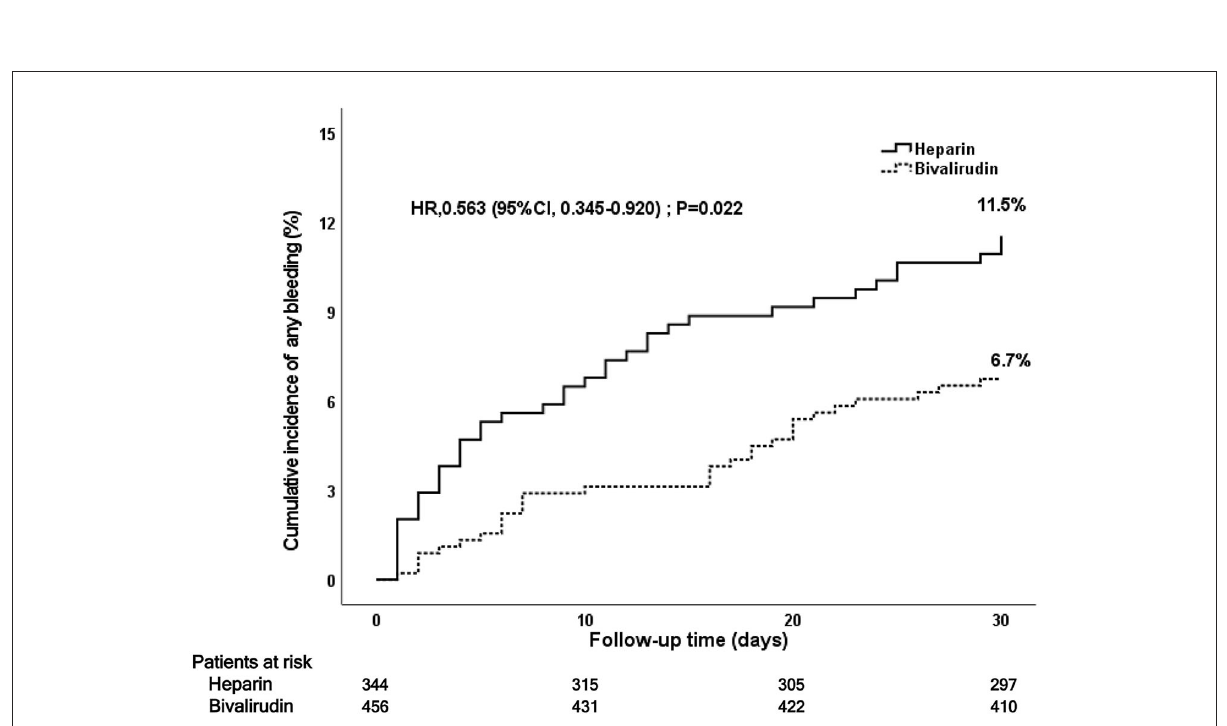
FIGURE4 Kaplan–Meier curve of post-PCI 30-day bleeding events. PCI, percutaneous coronary